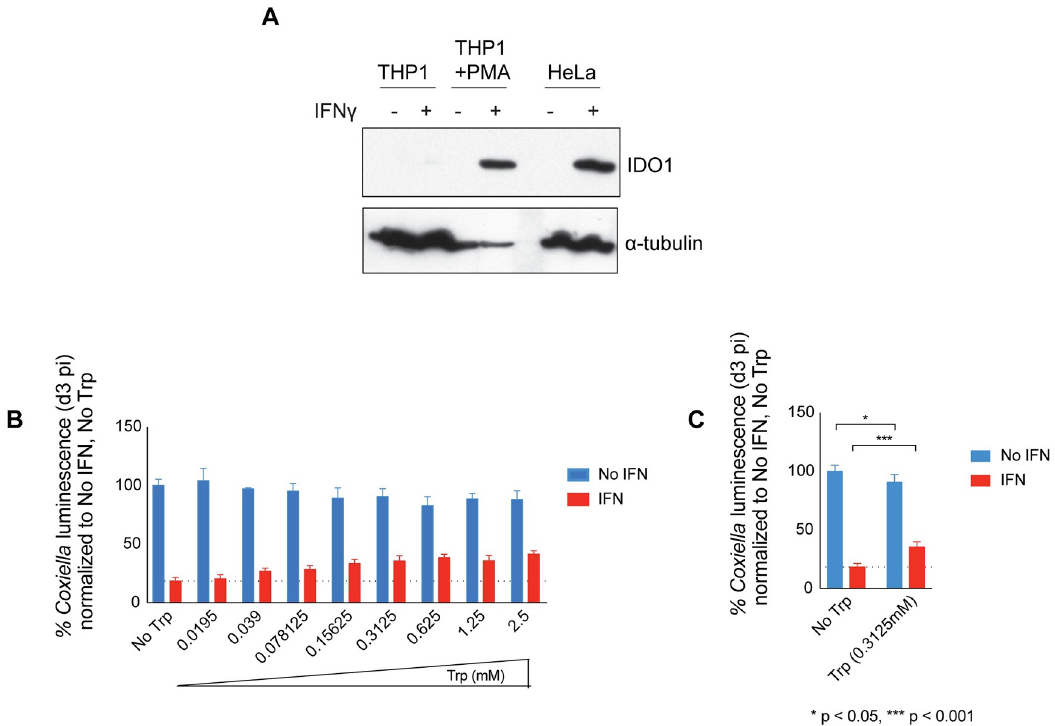
Fig 7. IDO1 contributes to IFN γ -mediated growth restriction of C . burnetii in human macrophages. Undifferentiated or PMA- differentiated THP1 cells and HeLa cells were left untreated or treated with IFN γ . On d2 post IFN γ -treatment, cell lysates were collected and IDO1 protein levels observed by immunoblotting (A). PMA-differentiated THP1 macrophages were infected with C . burnetii lux and treated with IFN γ in the presence or absence of additional Trp at the concentrations indicated. Luminescence values on d3 pi were normalized to that of untreated, no-Trp supplemented cells (B). Data specific for Trp concentration 0.3125mM from Fig 7B is represented in Fig 7C. Dotted lines indicate the normalized luminescence values for IFN γ -treated, no-Trp supplemented cells based on which statistical significance was calculated (B and C).